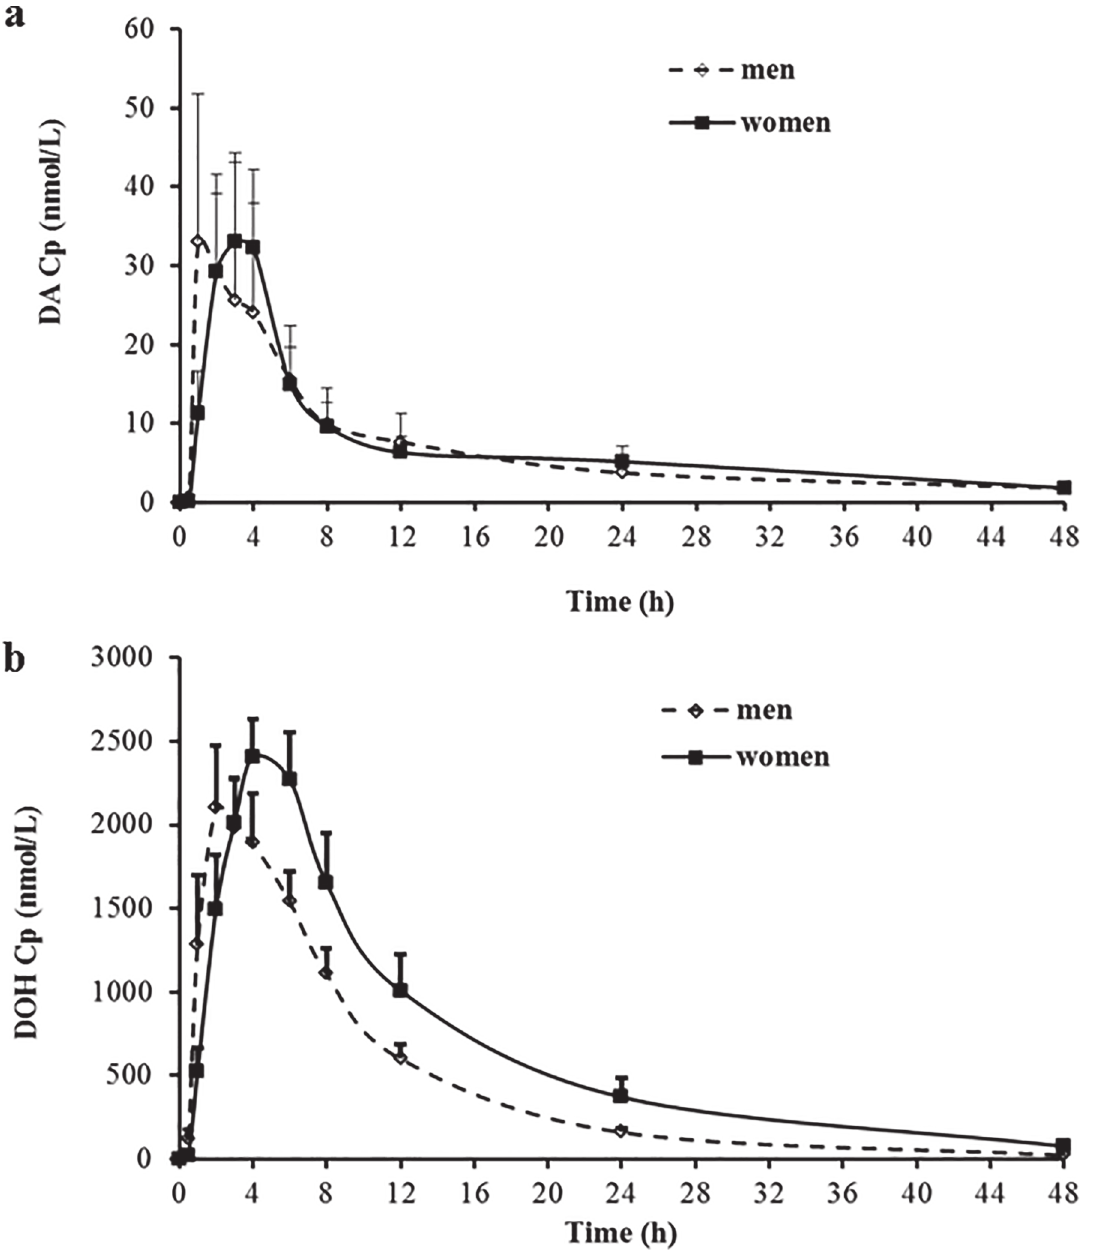
Fig 4. Gender comparison of plasma concentration (Cp)-time profiles of pyranocoumarins after a single oral dose of Cogni.Q. (a) DA. (b) DOH. Mean ± SEM. Men (n = 10) and women (n = 10).